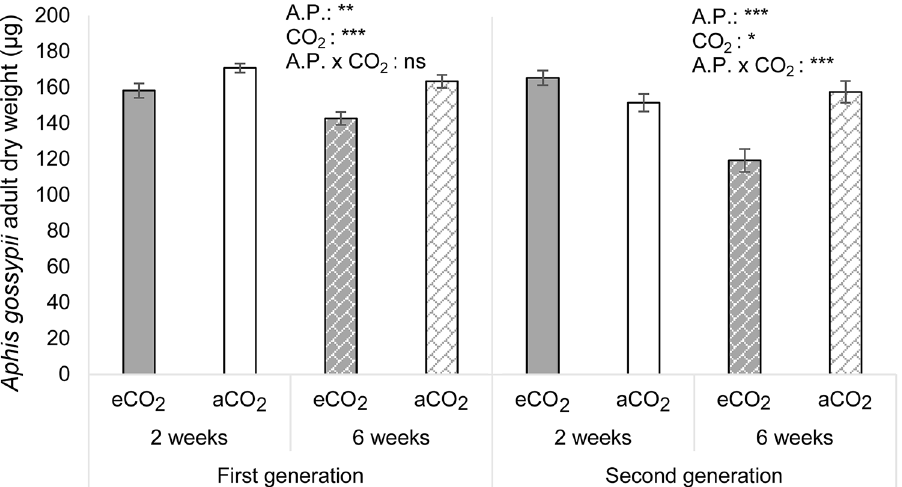
Figure 5. Aphis gossypii body mass. Dry weight (µg) of adult Aphis gossypii (mean ± SE) developed under ambient (aCO 2 ) (400 ppm) or elevated (eCO 2 ) (700 ppm) CO 2 , on melon plants previous acclimated for 2 or 6 weeks to the respective CO 2 concentration. Values are the average of sets of 50 synchronized adults (n = 12). First and second generation were examined separately . *(P ≤ 0.05), **(P ≤ 0.01) and ***(P ≤ 0.001) when statistically significant differences were found, ns (no significant differences) (Two-way ANOVA and LSD tests). A.P. = Acclimation Period to the respective CO 2 concentration.